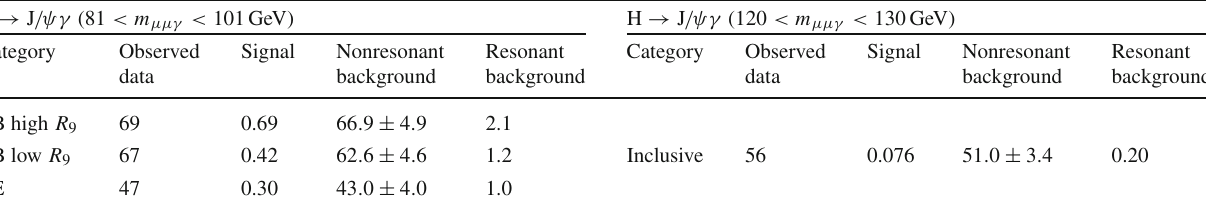
Table 1 The number of observed Z or H boson events, the expected signal yields, the expected nonresonant background with uncertainties estimated from the fit (described in Sect. 5), and the expected reso- Z → J /ψγ (81 < m μμγ <